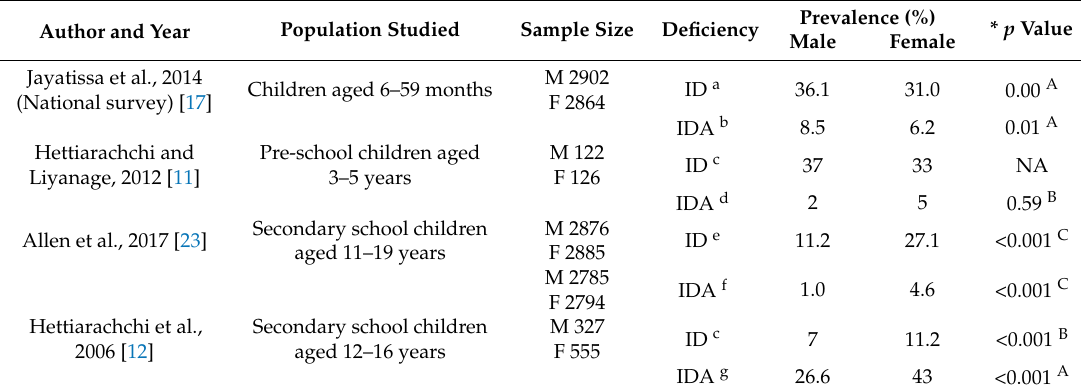
Table 4. Prevalence of ID and IDA according to